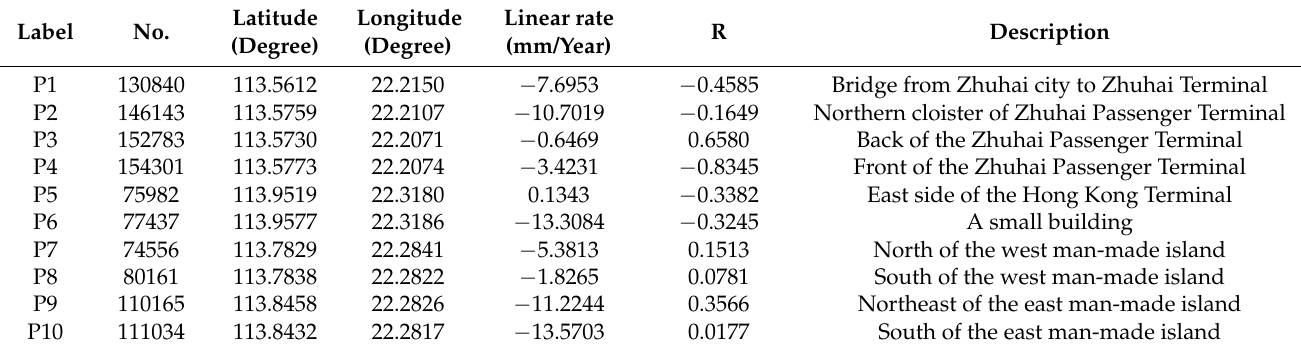
Figure 9. Close-ups of ( a ) a part of the bridge connecting Zhuhai city and the Zhuhai Passenger Terminal; ( b ) northern part of the Zhuhai Passenger Terminal; ( c ) the IS4; ( d ) the IS2; and ( e ) IS3. The background is the satellite image from Google Earth. P1–P10 are ten examples which are listed in Table 1 and discussed in Section 3.2. Table 1. Latitudes and Longitudes of P1–P10 shown in Figure 9. The P3 and P4 are of a correlation coefficient above 0.6 and lower than − 0.6,